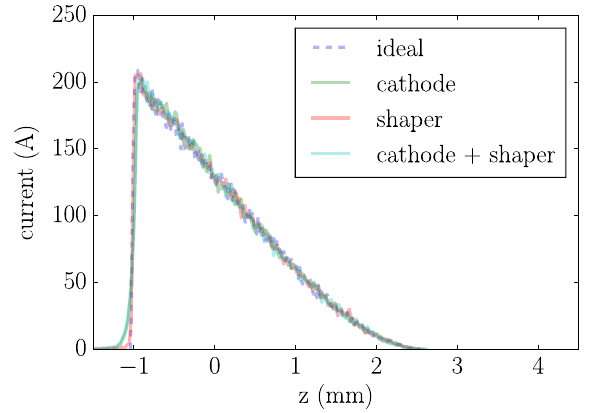
7. Comparison of the final electron-bunch current at s ¼ 50 cm from the cathode surface for the four cases considered in Fig. 6. The “ cathode ” and “ shaper ” respectively correspond to the inclusion of the cathode response time and shaper bandwidth limitation in the initial particle distribution at s ¼ 0 while the ideal case is given by Eq. (19) with α ¼ 2 and τ ¼ 15 ps. The head of the bunch corresponds to z > 0